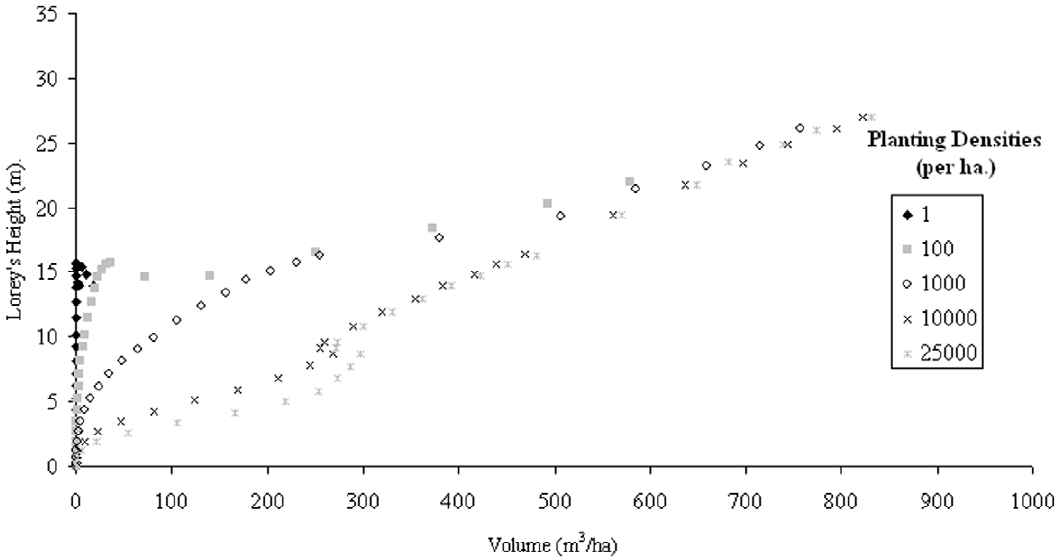
Figure 3. AbiesAlba H Lorey against stand volume over a period of 100 years.